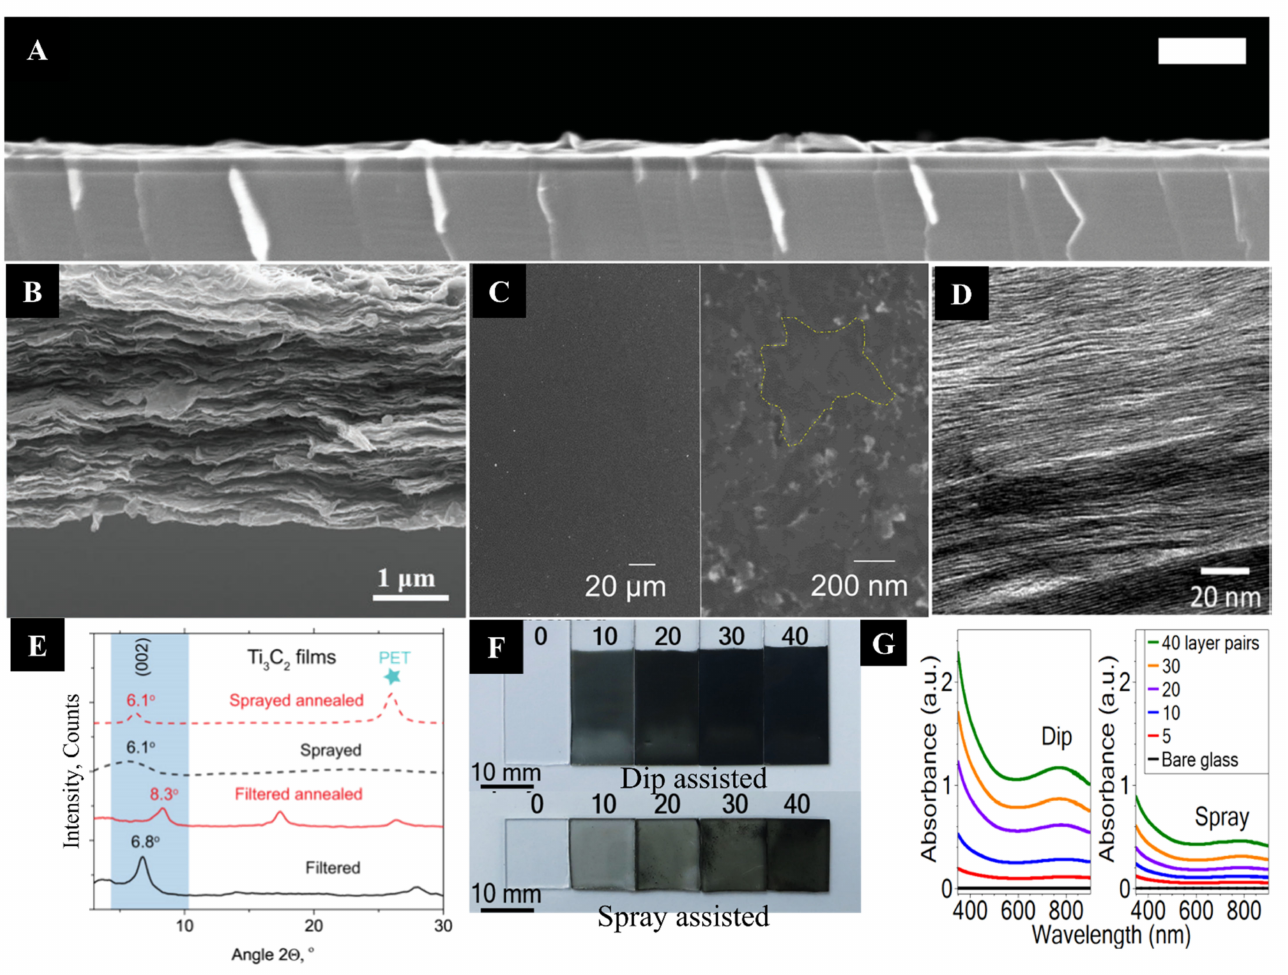
Figure 9. SEM images of ( A ) Ti 3 C 2 thin film prepared by using SCM Scale (1 µ m) (reproduced with permission [80]. Copyright 2016, Wiley-VCH); ( B ) The vacuum filtration method assisted the formation of Ti 3 C 2 thin film (reproduced with permission [80]. Copyright 2016, Wiley-VCH); ( C ) Cross-sectional images of Ti 3 C 2 thin film synthesized by using the spray-coating method (repro- duced with permission [88]. Copyright 2016, Wiley-VCH); ( D ) SEM image of drop cast V 2 C MXene film, (reproduced with permission [99]. Copyright 2019, American Chemical Society); ( E ) X-ray diffraction (XRD) patterns of Ti 3 C 2 MXene thin films prepared by VAF (solid black line) and after treatment in vacuum at 150 ◦ C (solid red line) and spray coating of Ti 3 C 2 film (black dashed line), and heated in film in vacuum at 150 ◦ C (red dashed line); ( F ) Physical images of dip and spray assembled multilayer Ti 3 C 2 coatings of a different number of layer pairs on a glass substrate, (reproduced with permission [140]. Copyright 2018, Wiley-VCH); ( G ) UV-vis absorption spectra of Ti 3 C 2 at 770 nm wavelength vs. the number of layer pairs on a glass substrate (reproduced with permission